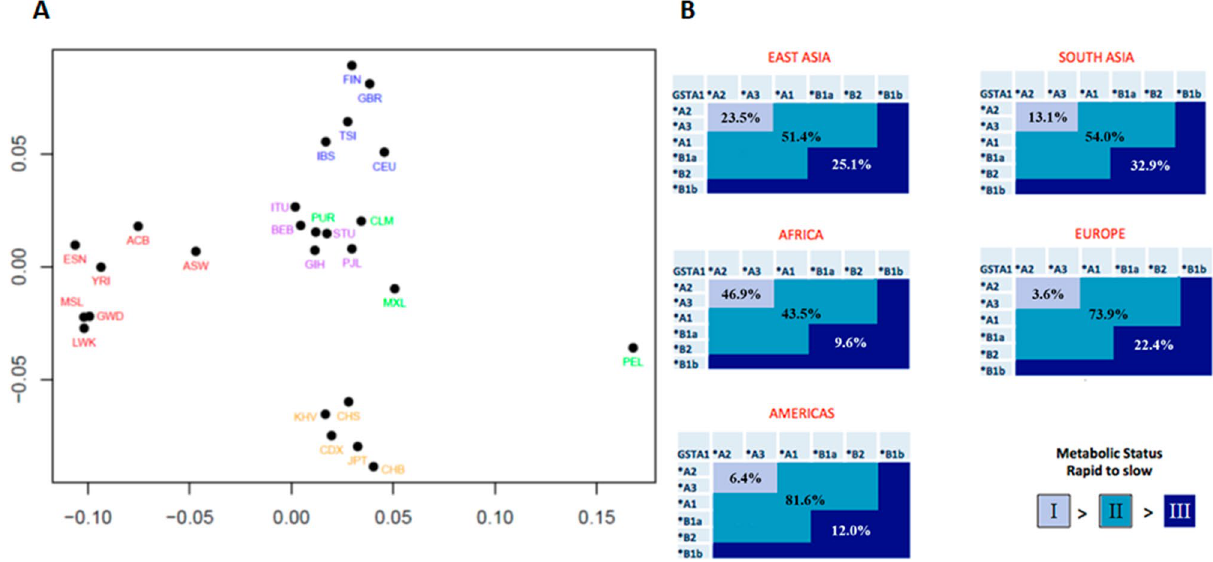
Figure 1. FST analysis of human super- and sub-populations ( A ) and world-wide frequencies of GSTA1 metabolic category ( B ). ( A ) red—African, green—American, light brown—East Asian, blue—European, violet—South Asian sub-populations. ( B ) grey-blue—fast metabolisers, blue—intermediate metabolisers, dark blue—slow metabolisers.